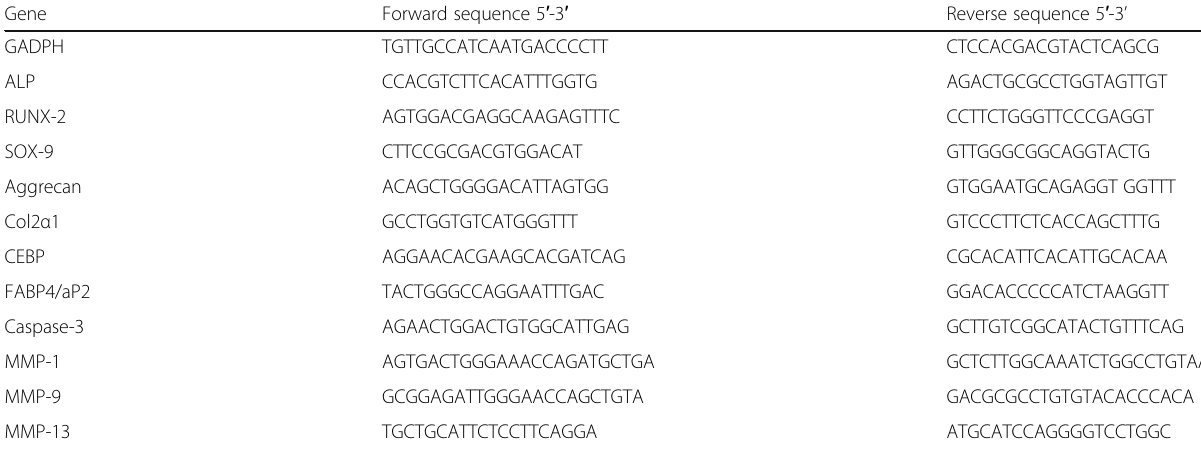
Table 2 Primer sequences for qRT-PCR